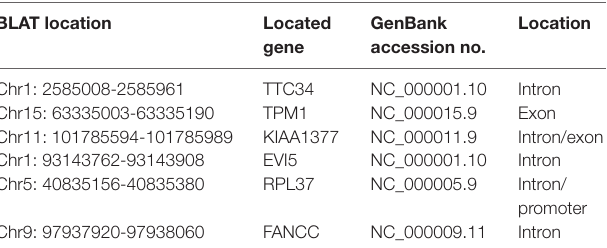
TABLE 4 | MiR-373 binding sequences identified by next-generation